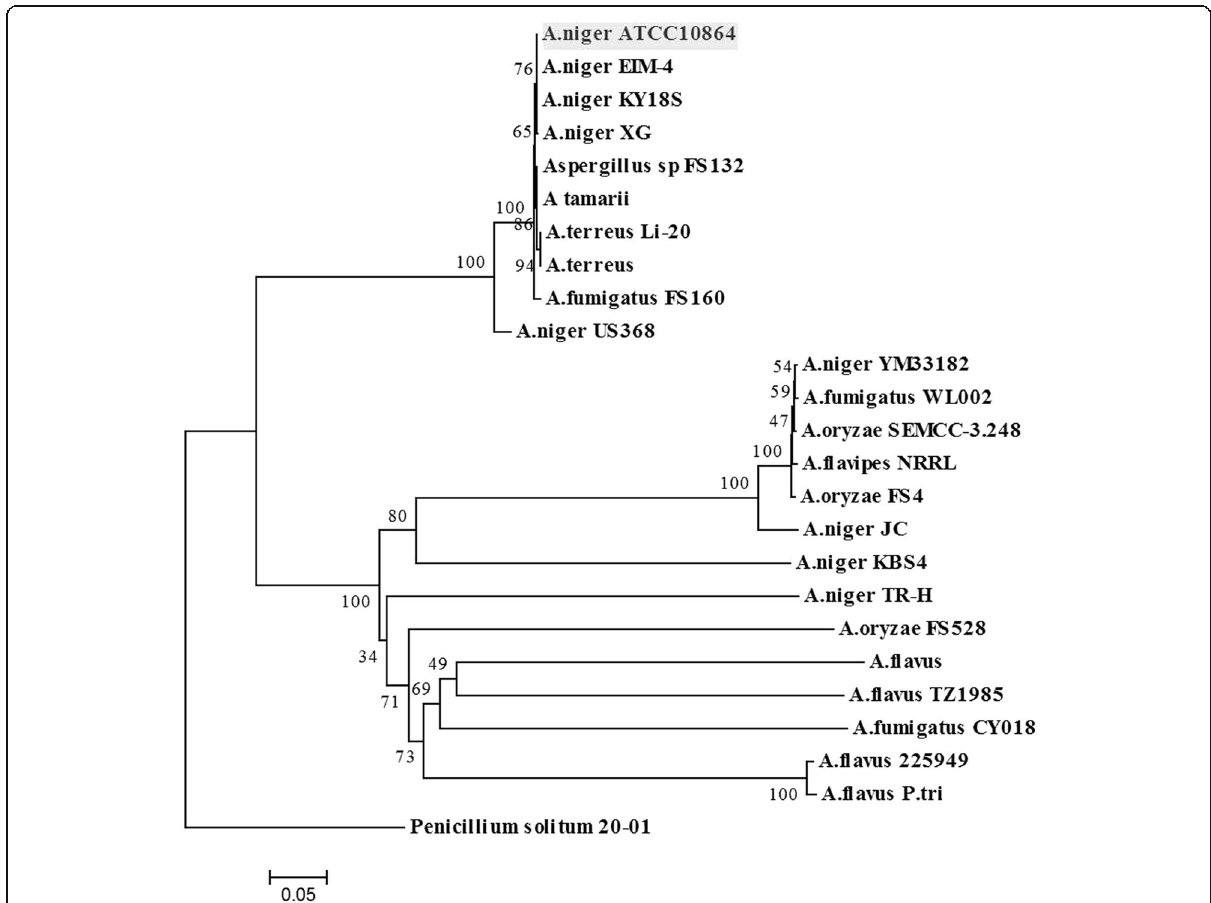
Fig. 2 Phylogenetic tree showing the close relationship of A. niger strain ATCC 10864 ( grey block ) with other A. niger strains based on aligned sequences of the 18S rRNA gene. Multiple sequence alignment was performed using ClustalX program and the phylogeny was calculated using maximum likelihood method based on the Tamura-Nei model. The bootstrap value was inferred from 1000 replicates. Penicillium solitum is considered as the outgroup for this analysis. The whole analysis was carried out using MEGA5 package